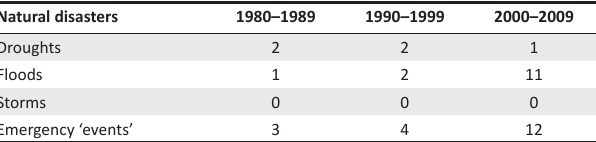
TABLE 2: Occurrence of natural disasters from 1980 to